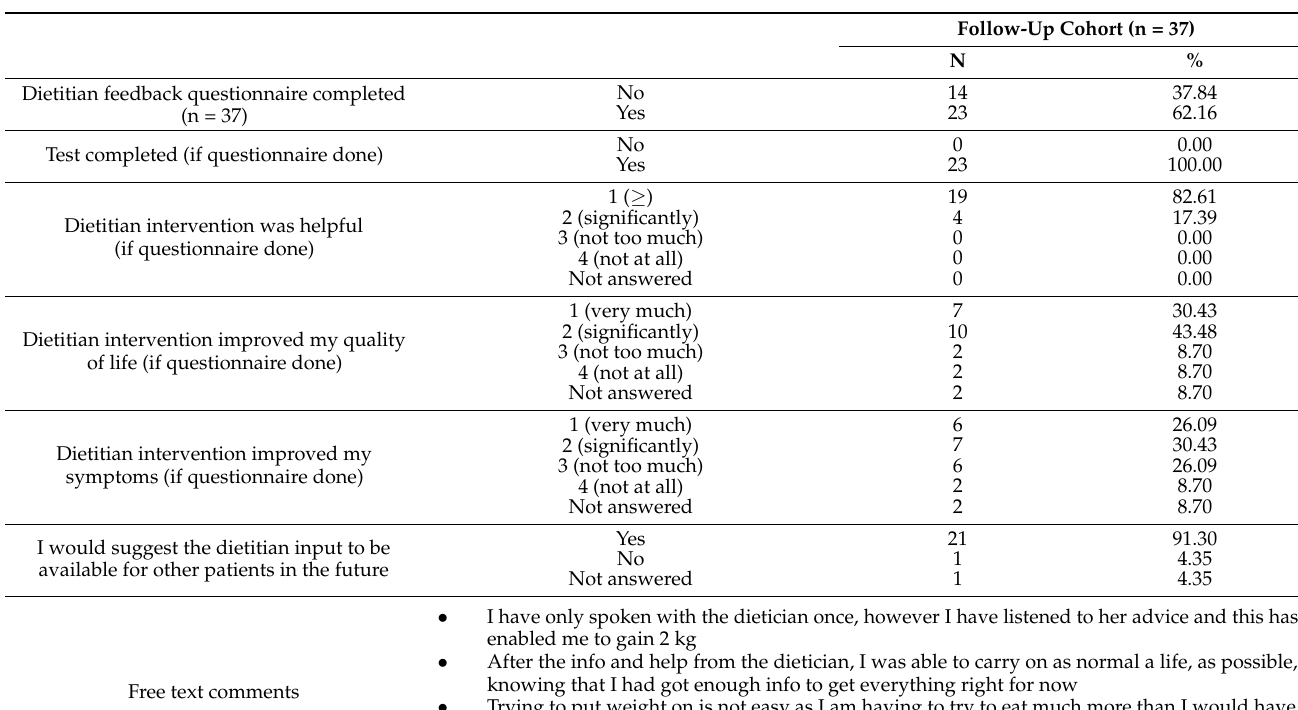
Table 2. Patient feedback of dietetic input in the follow-up